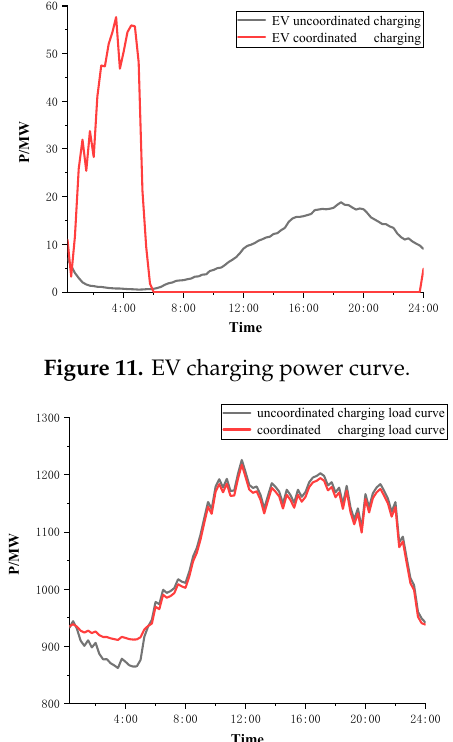
Figure 12. Load curves with EV charging.